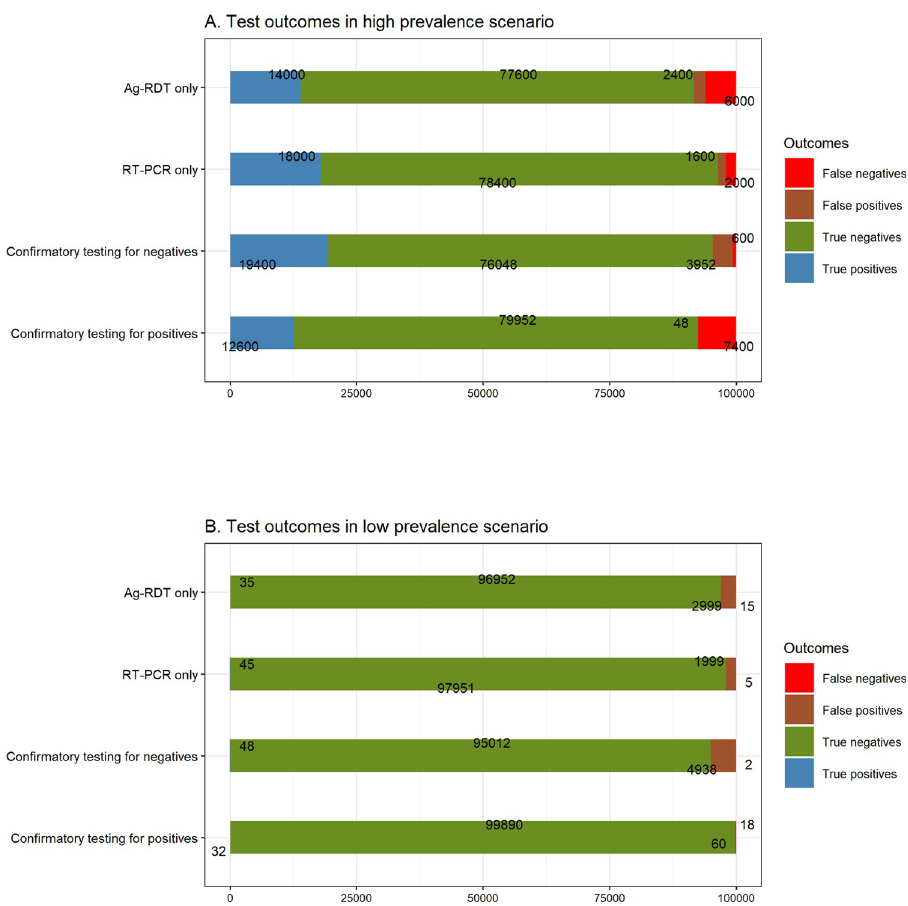
Fig 3. Test outcomes by testing strategy in (A) a high-prevalence scenario and (B) a low-prevalence scenario.